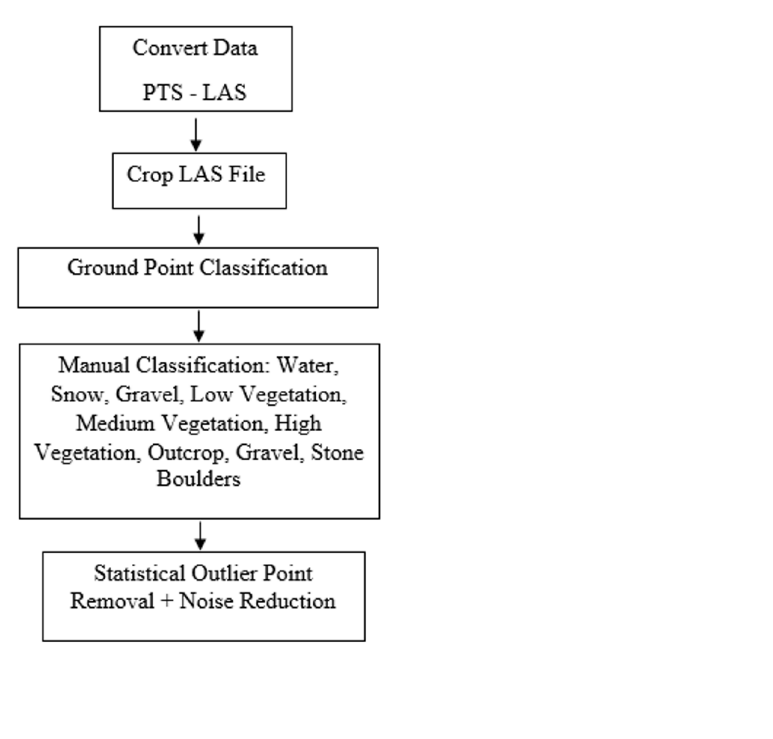
Figure 2: Step-by-step classification sequence from original point cloud dataset to the individually classified elements, using open source LAStools and CloudCompare